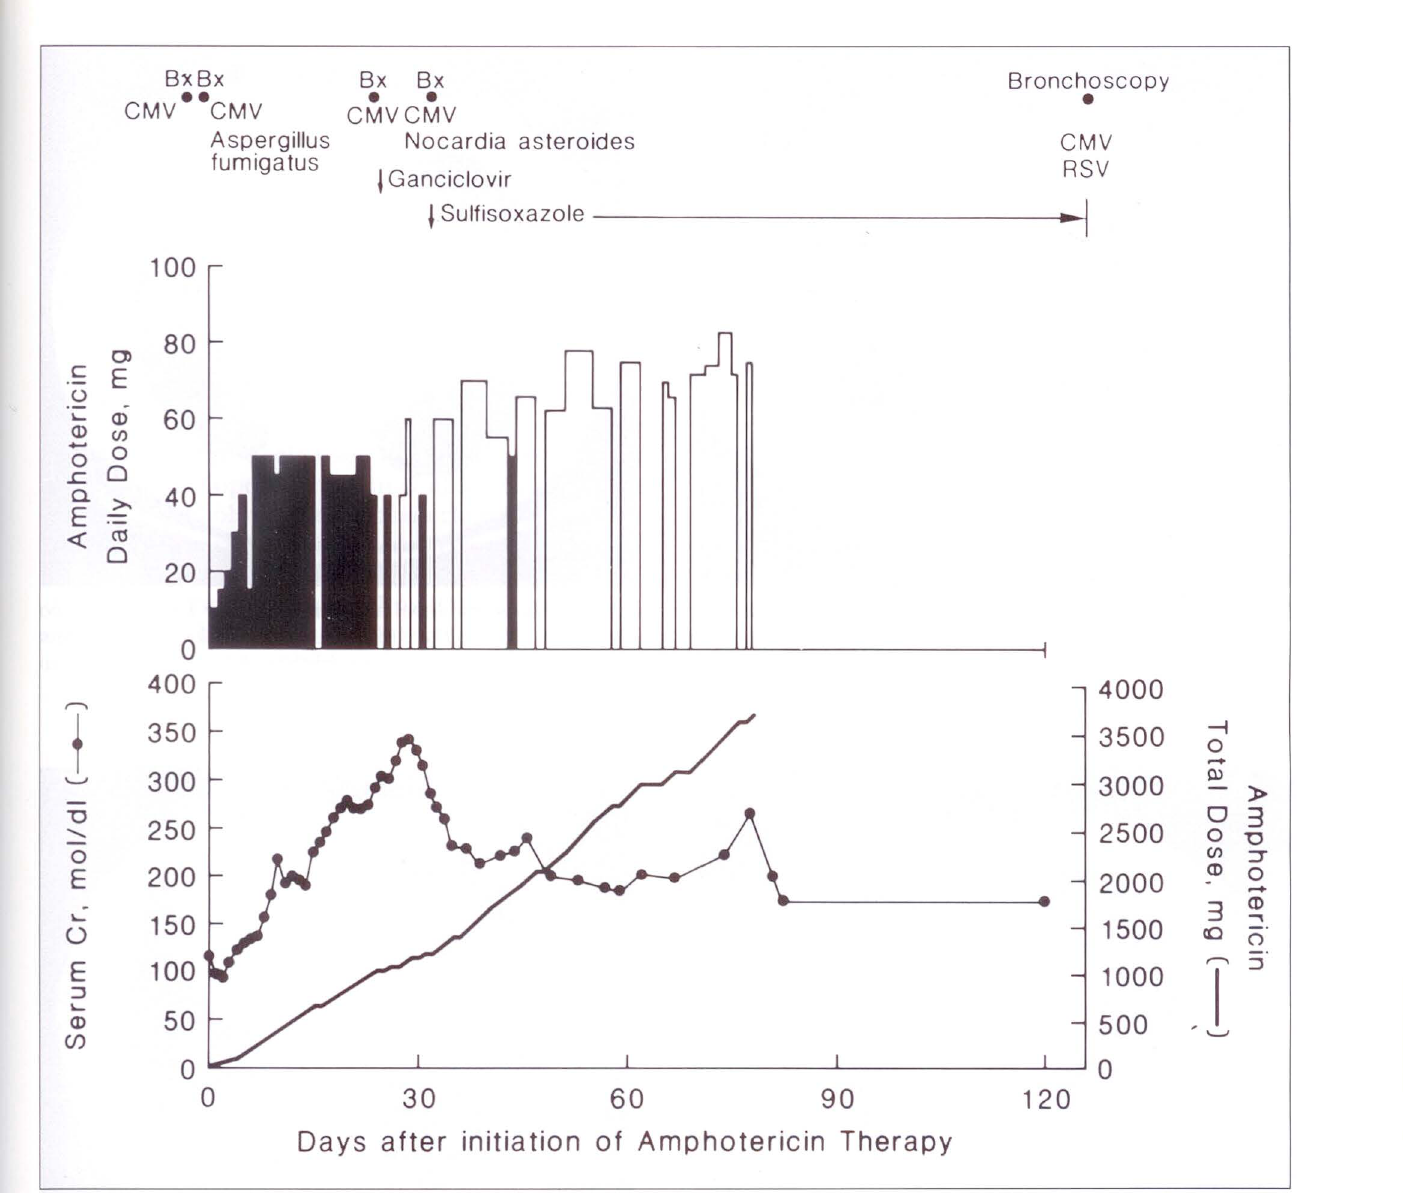
Figure 2) Summary of patient's course. The times of the computed tomography-guided needle biopsies (Bx) and bronchoscopy are noted at the top of the figure along with the respective microbial isolates. A bar grap/1 illustrates the daily amphotericin B dose (Shaded bars Conventional amphotericin B: Clear bars Liposomal amphotericin B). The